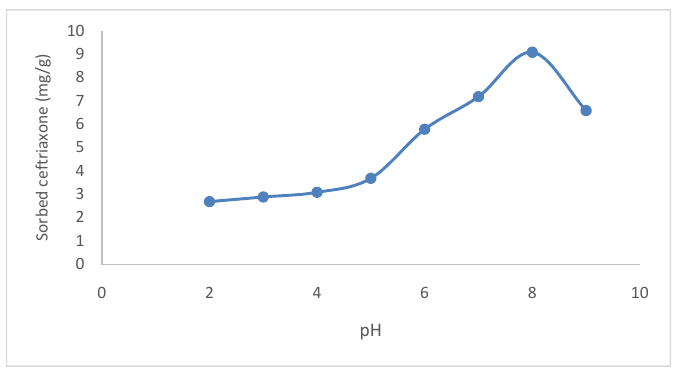
Fig.2. Magnetization hysteresis loop behavior of Fe